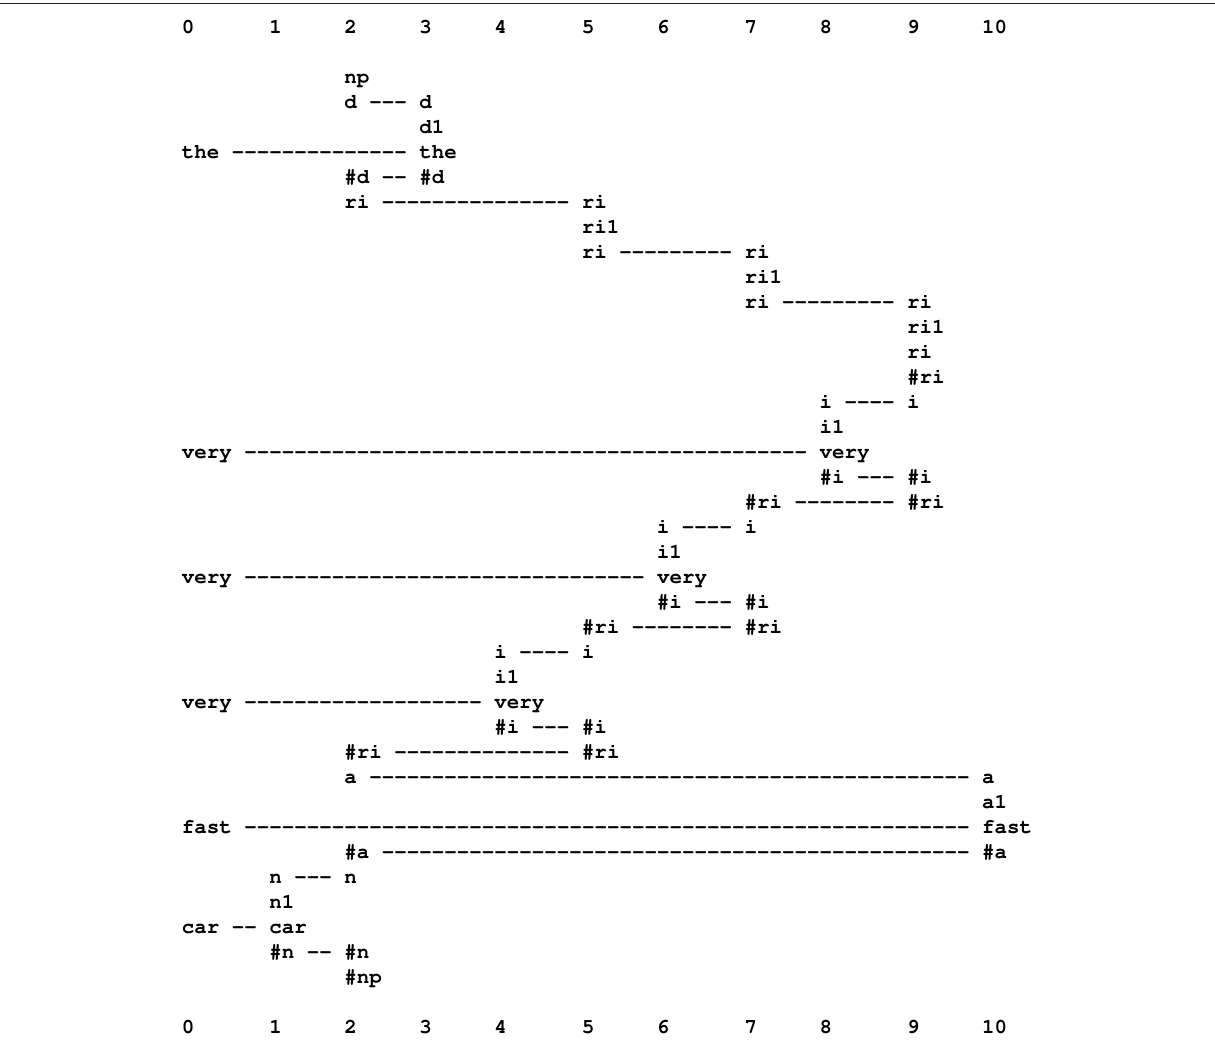
FIGURE 8 | A multiple alignment produced by the SP computer model showing how recursion may be modeled in the SP system. Adapted from Figure 3 in Wolff (2016), with